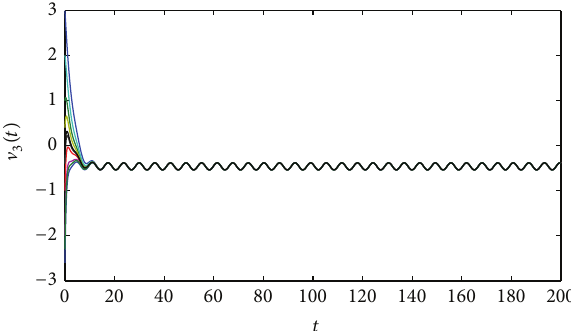
Figure 6: Transient response of state variables V 3 (𝑡) of Example